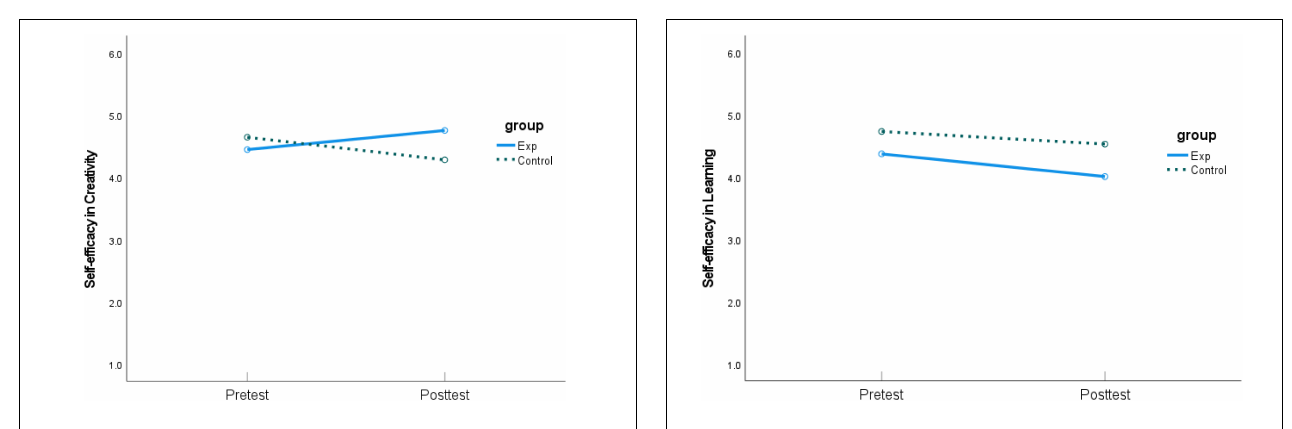
FIGURE 2 | Means of pretest and posttest on self-efficacy in creativity . FIGURE 3 | Means of pretest and posttest on self-efficacy in learning English.